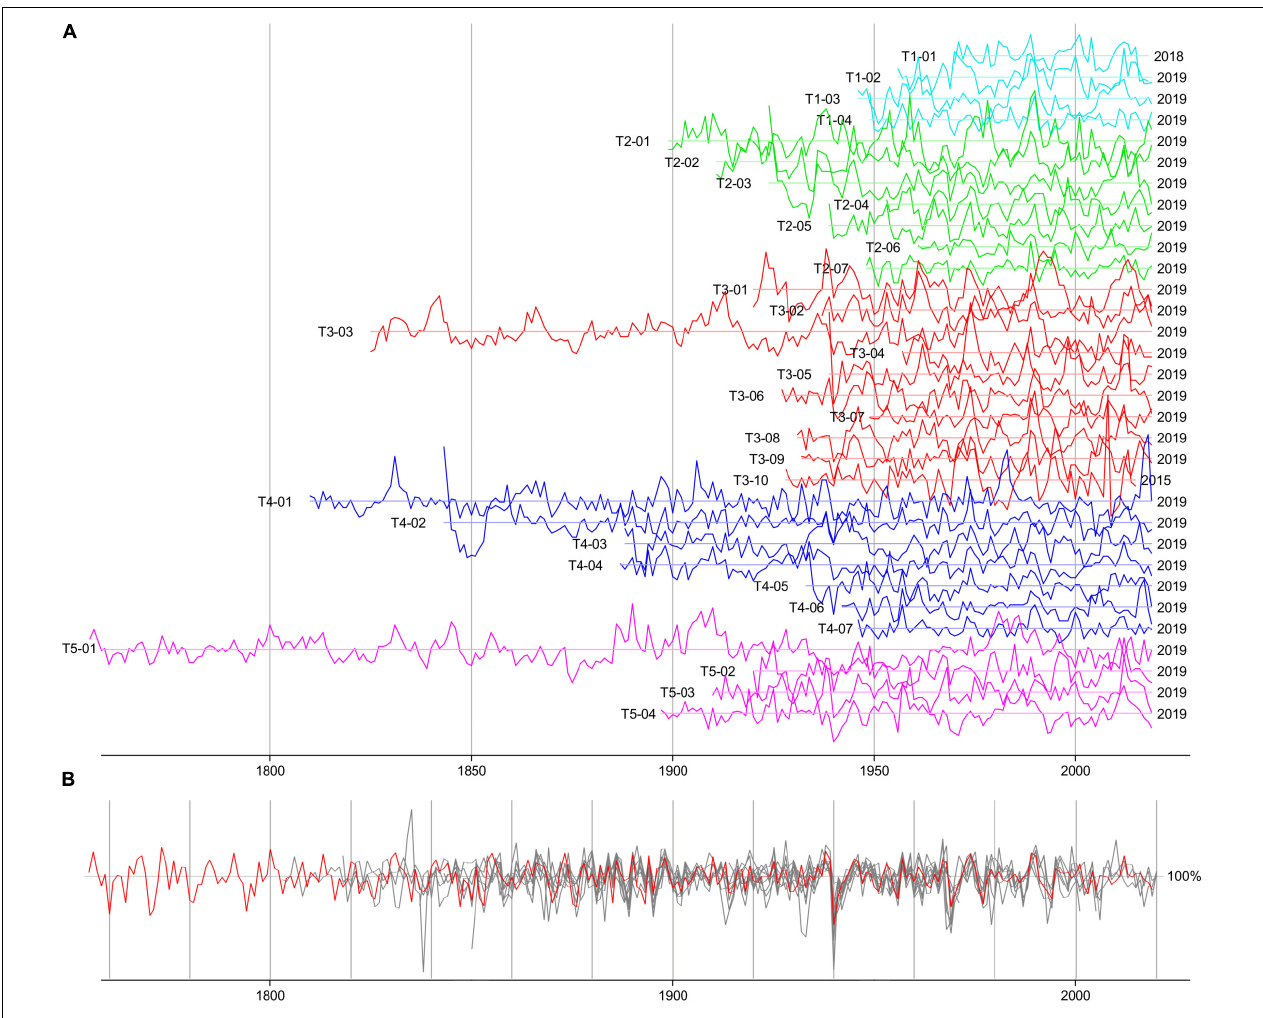
FIGURE 3 | Graphs of detrended TRW series for 32 pines along the five transects (T1–T5), in synchronous arrangement (A) . Graph of the chronology (red line) compiled from the TRW data for these pines, overlaid in synchronous arrangement on the graphs of absolute reference chronologies for pine (A–K) (semi-logarithmic scale; B